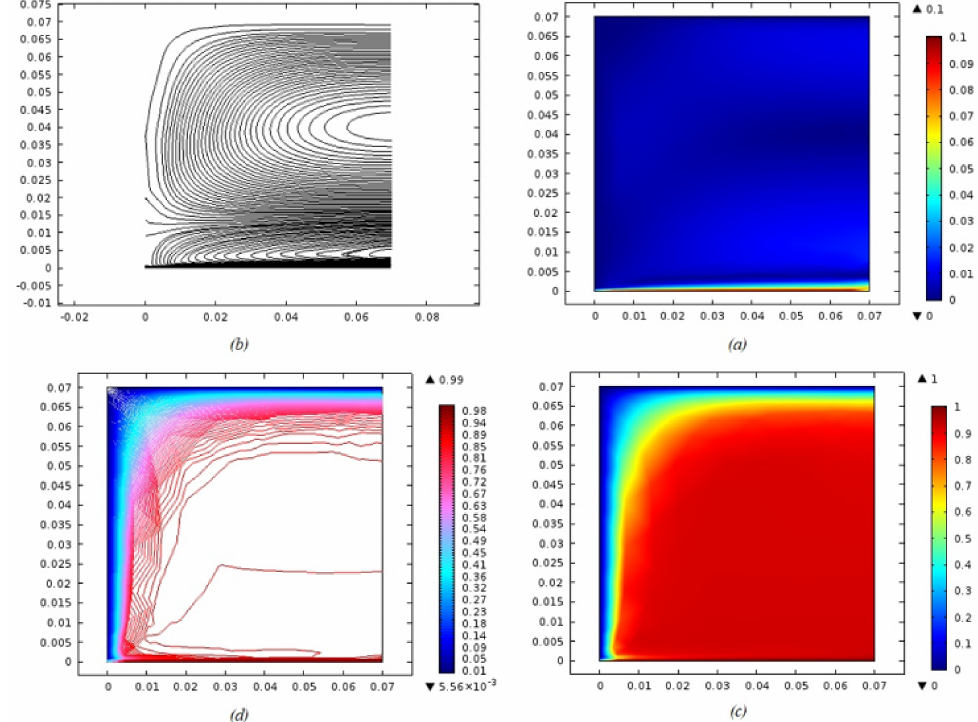
Figure 16. ( a ) Surface plot for velocity; ( b ) streamlines; ( c ) surface plot for temperature; ( d ) isothermal contours using M = 0.5, k p = 1, U w =